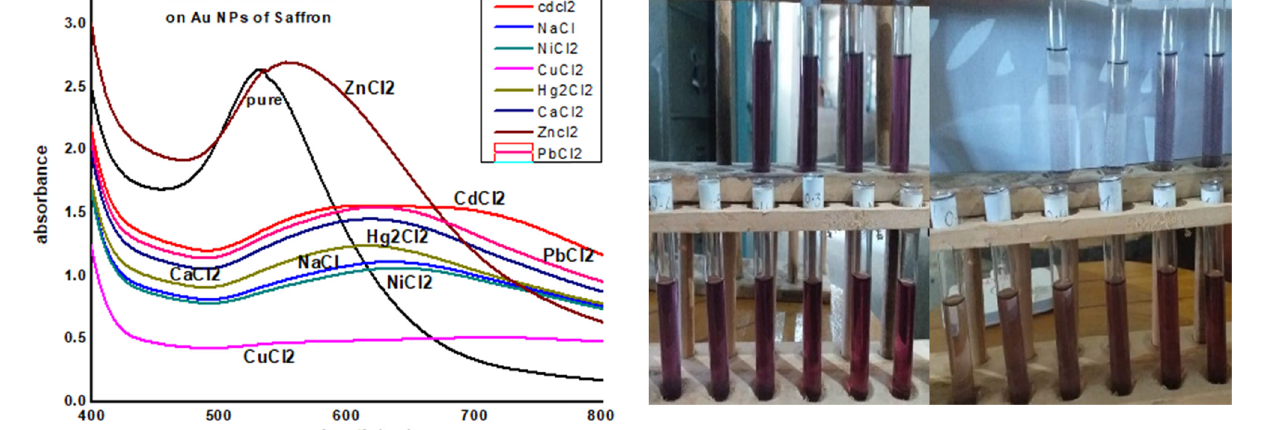
Figure 10: E ff ect of NaCl on sa ff ron stigma AuNPs ( SS - AuNPs ) ( after 24 h )